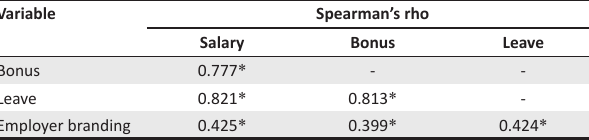
TABLE 4: Spearman’s rho tests for compensation and employer branding. Variable